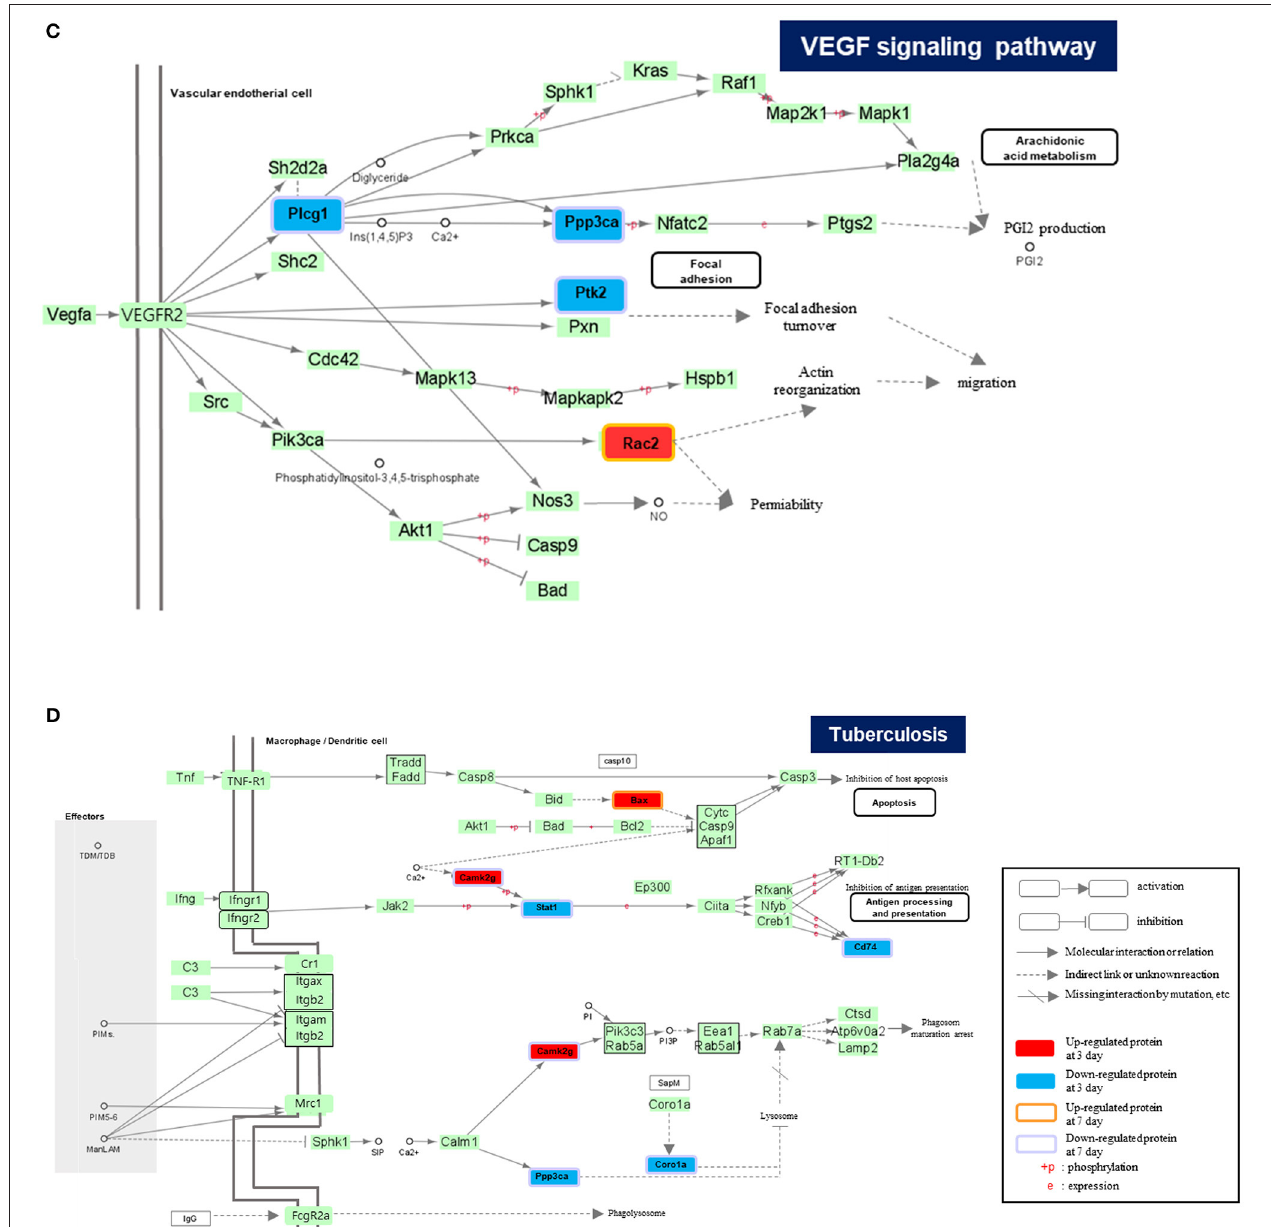
FIGURE 2 | KEGG pathway analysis of common DEPs between 3 and 7 days of dose group in irradiated rat. (A) The result of KEGG pathway analysis, filtered with FDR value lower than 0.05. Among those, the pathways that directly related with cardiovascular activity or associated disease are plotted, which are (B) Regulation of actin cytoskeleton, (C) VEGF signaling pathway, and (D)